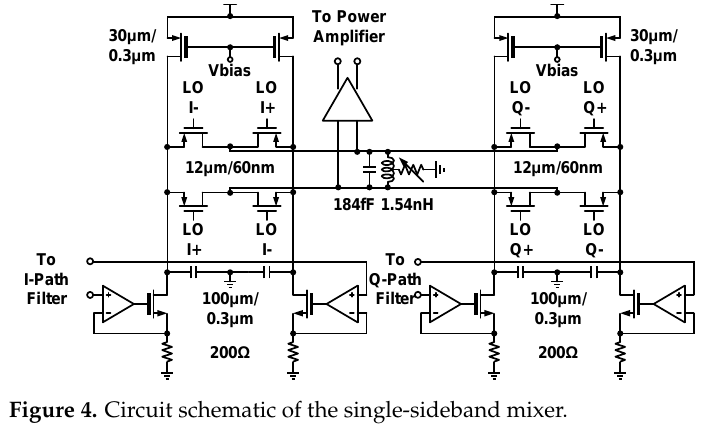
Figure 4. Circuit schematic of the single-sideband mixer.